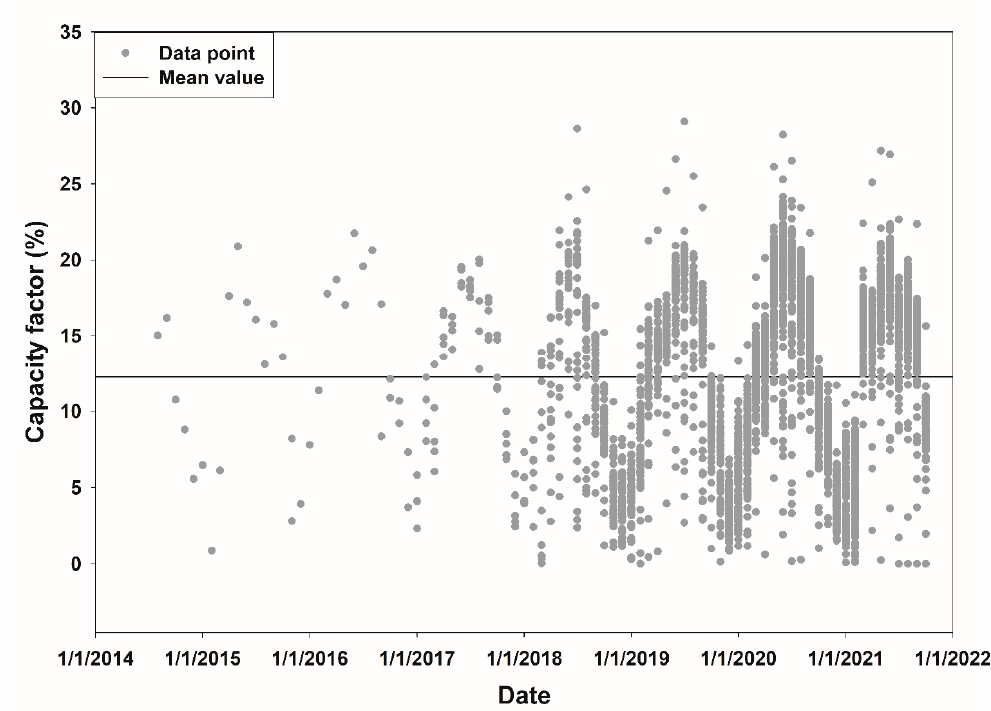
Figure 3. Monthly capacity factor values from 2014 to 2021 for 120 NYS-based solar PV systems, data collected from [25].